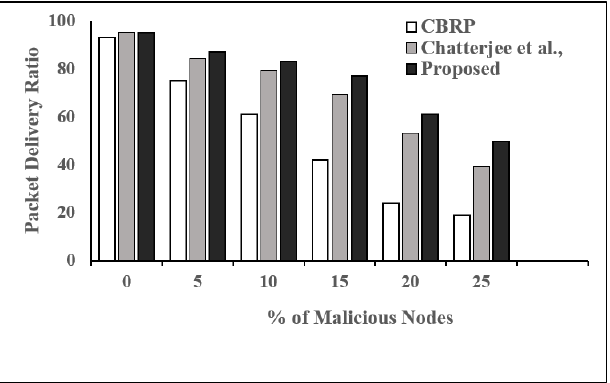
Figure 7. Packet delivery ratio vs. number of malicious nodes.